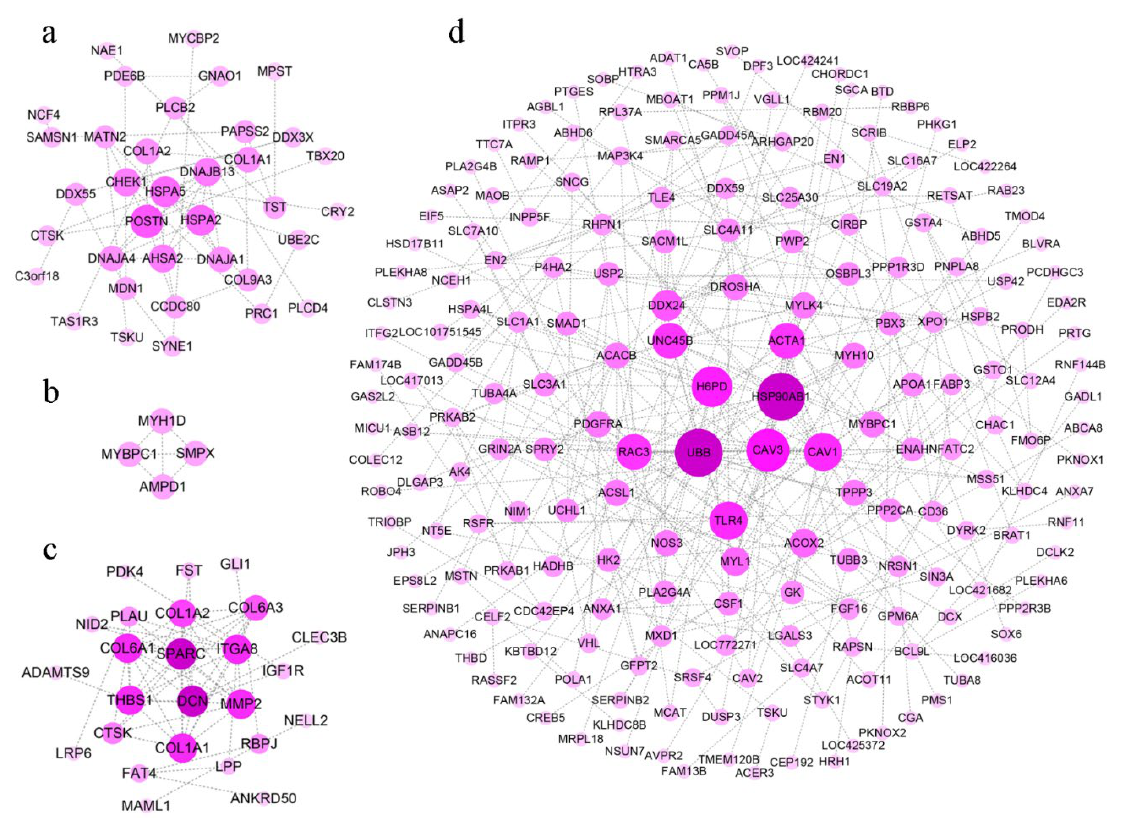
Figure 6. The protein-protein interaction network based on the DEGs between line S and line D. The protein-protein interaction network of DEGs in pituitary ( a ), breast muscle ( b ), thigh muscle ( c ), and liver ( d ) were analyzed and visualized by String and Cytoscape. The darker dots in the center indicate higher levels of gene interaction degree.